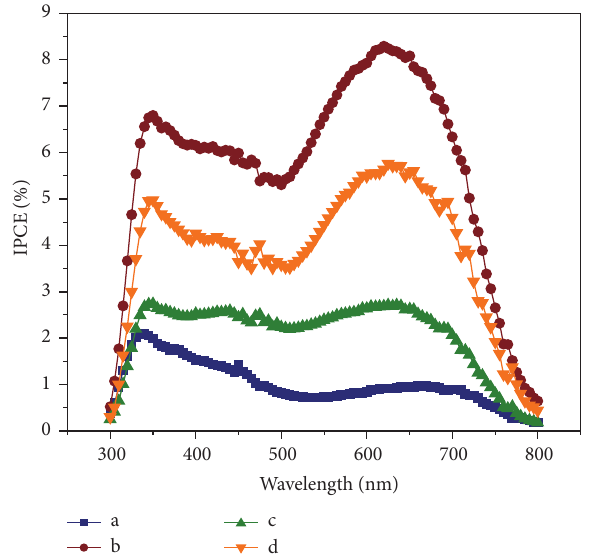
Figure 5: IPCE plot of PCPDTTBTT:PCBM solar cells: A: without thermal annealing, B: thermal annealing at 80 ∘ C, C: thermal annealing at 100 ∘ C, and D: thermal annealing at 120 ∘ C.